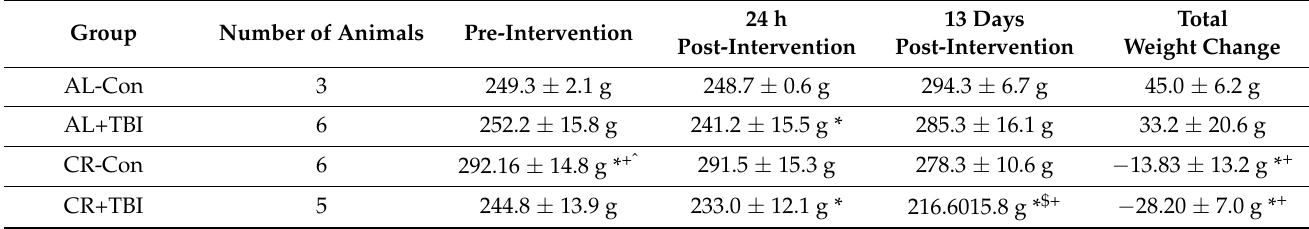
Table 1. TBI and CR significantly decreased body weight 24 h post-injury.